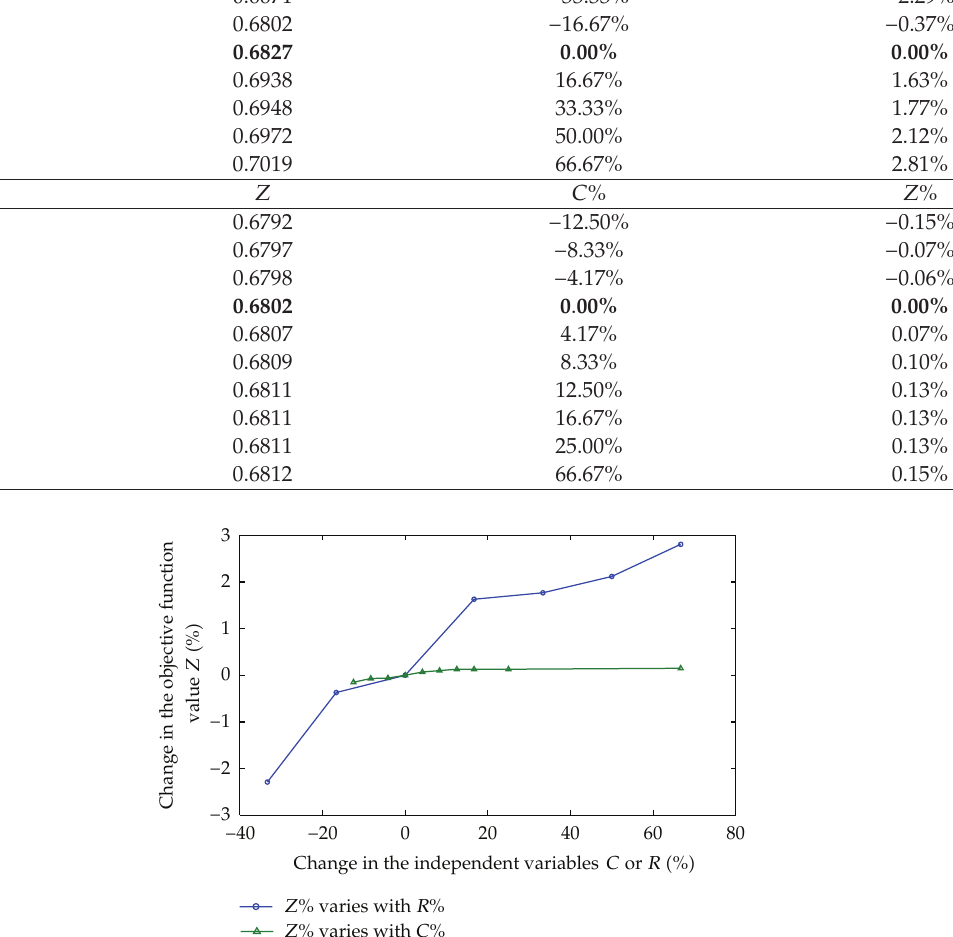
Figure 6: Comparison of the performance changes caused by C and R